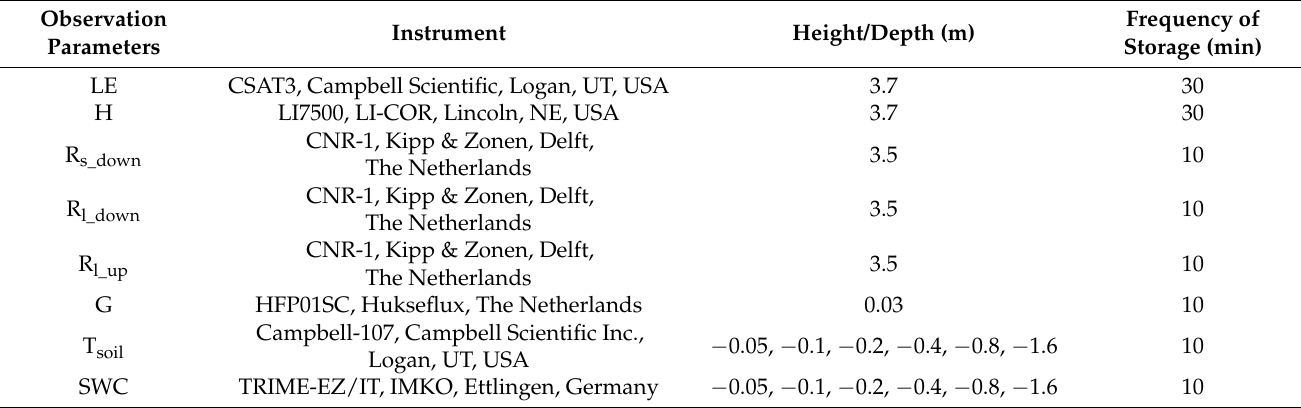
Table 2. Observation projects of flux